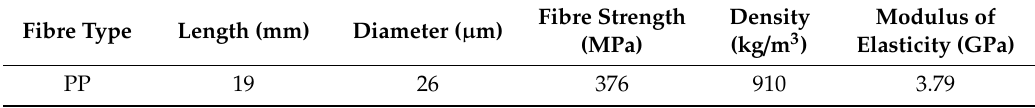
Table 4. Properties of polypropylene fibre.